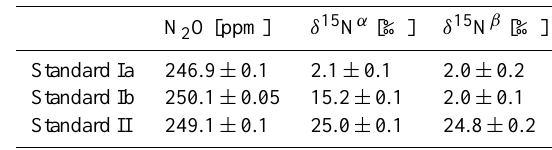
Table 1. N 2 O mixing ratios and relative differences of isotopic ra- tios δ 15 N α and δ 15 N β of secondary laboratory standards applied in the current project (the precision indicated is the standard error of the mean). Standard Ia was replaced by standard Ib 22